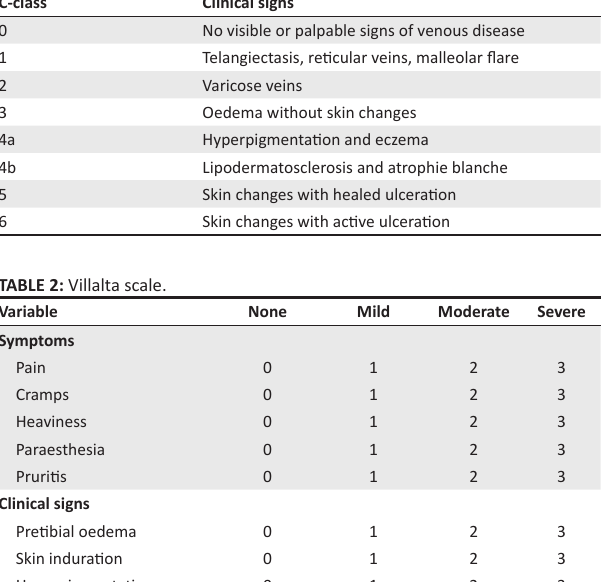
TABLE 1: Clinical parameters of the clinical, etiology, anatomic and pathology classification. C-class